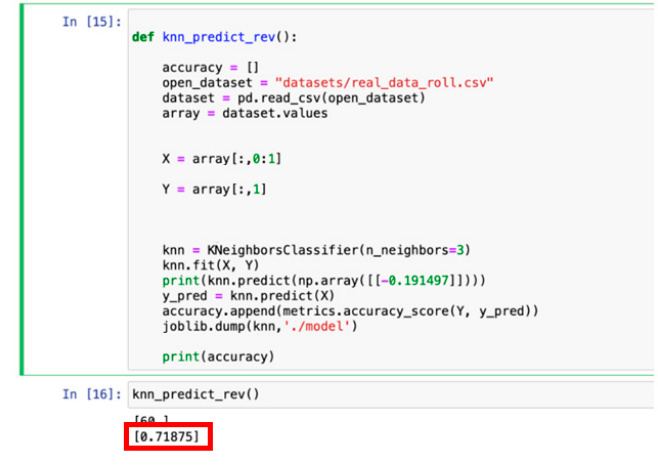
Figure 8. KNN training accuracy.